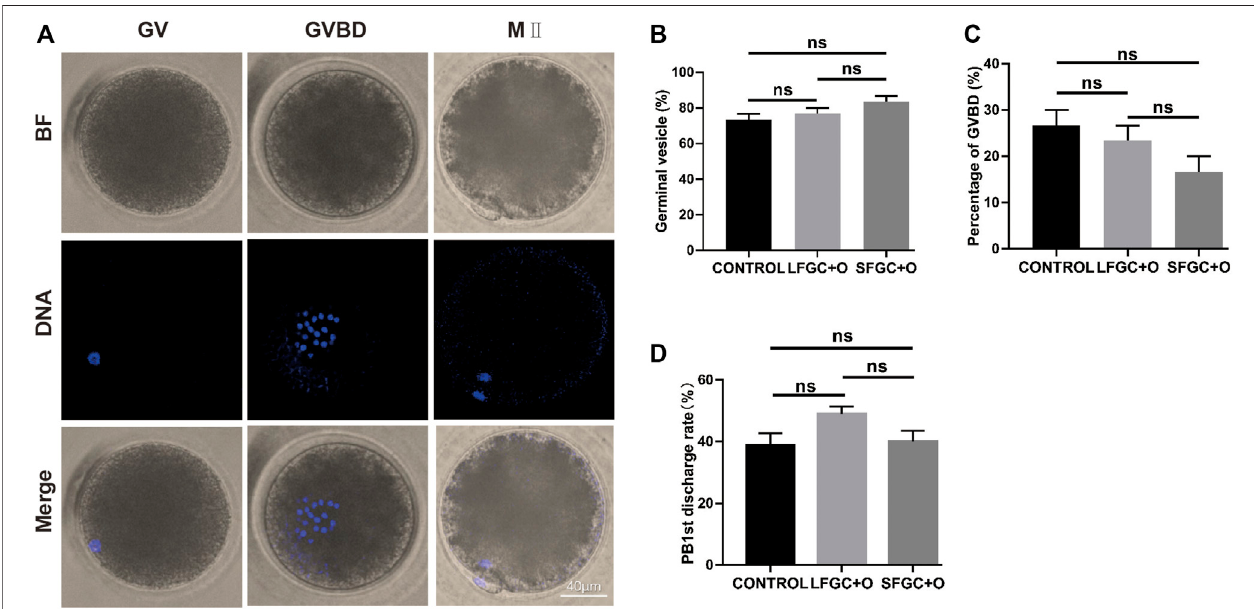
FIGURE 1 | Effects of GC co-culture on mare oocyte in vitro nuclear maturation. (A) Nuclear staining of oocytes in GV, GVBD, and MII stages. Scale bar = 40 µm. (B) Percentages of GV stage mare oocytes derived from the CONTROL, LFGC + O, and SFGC + O groups after 4 h of culture in vitro (30 oocytes per group). (C) Percentages of GVBD stage mare oocytes derived from the CONTROL, LFGC + O, and SFGC + O groups after 4 h of culture in vitro (30 oocytes per group). (D) PercentagesofMIIstagemareoocytesderivedfromtheCONTROL,LFGC+O,andSFGC+Ogroupsafter36 hofculture invitro (76oocytespergroup).Dataare shown as means ±